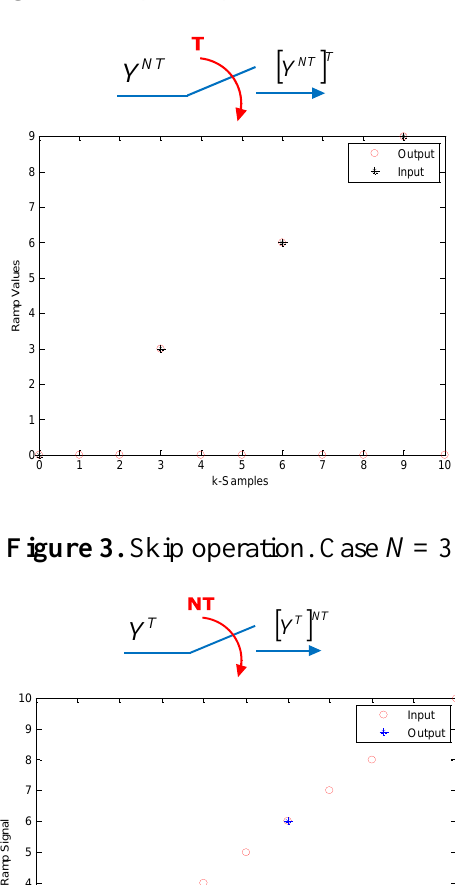
Figure 2. Expand operation. Case N = 3.